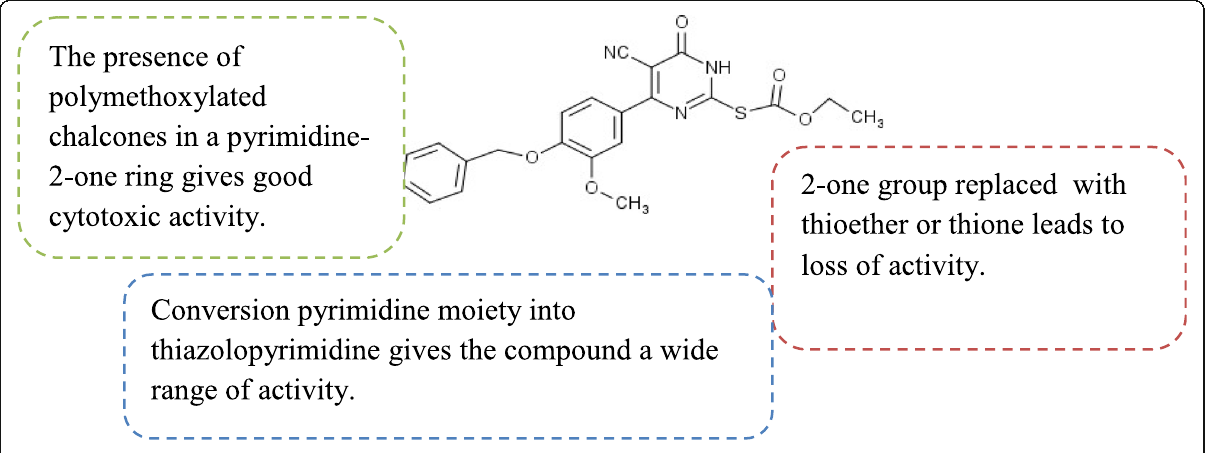
Fig. 11 Chemical structure and SAR studies of pyrimidines substituted with poly-methoxy chalcones compound